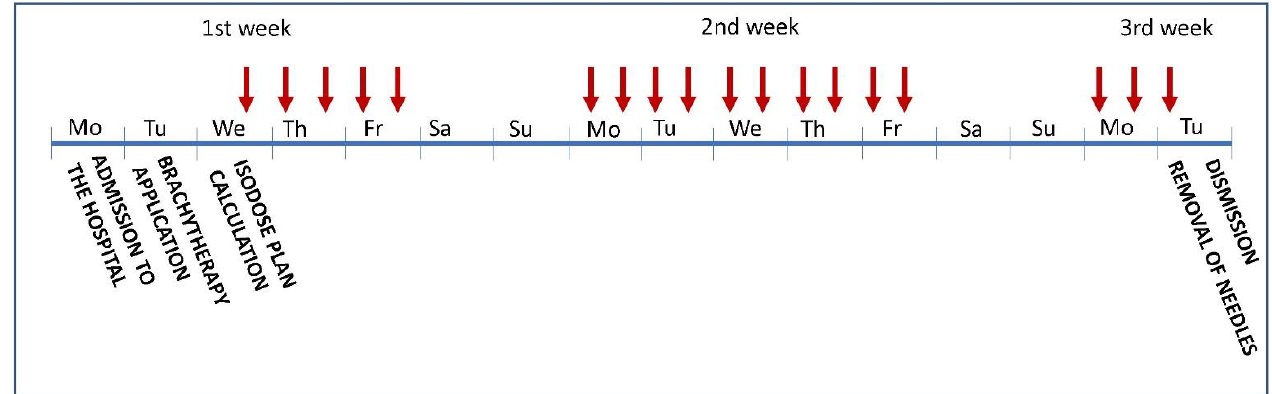
Figure 3. Scheme of treatment schedule. Red arrows indicate brachytherapy